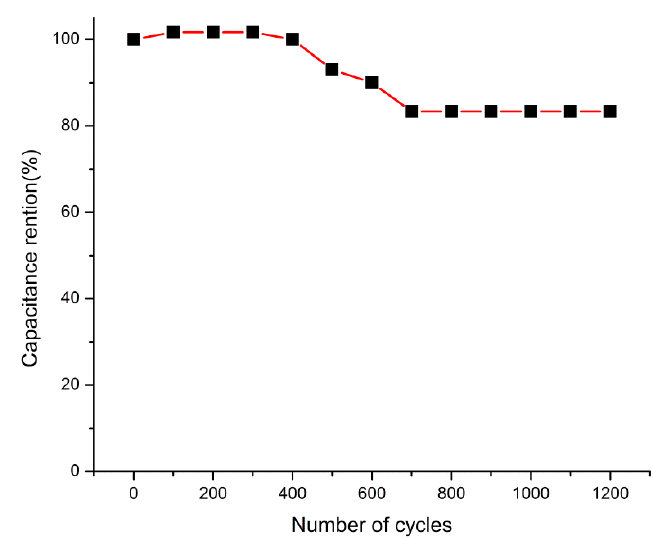
Figure 5. Cycle stability of the Ni@Cu-MOF-based supercapacitor at 1 A g − 1.